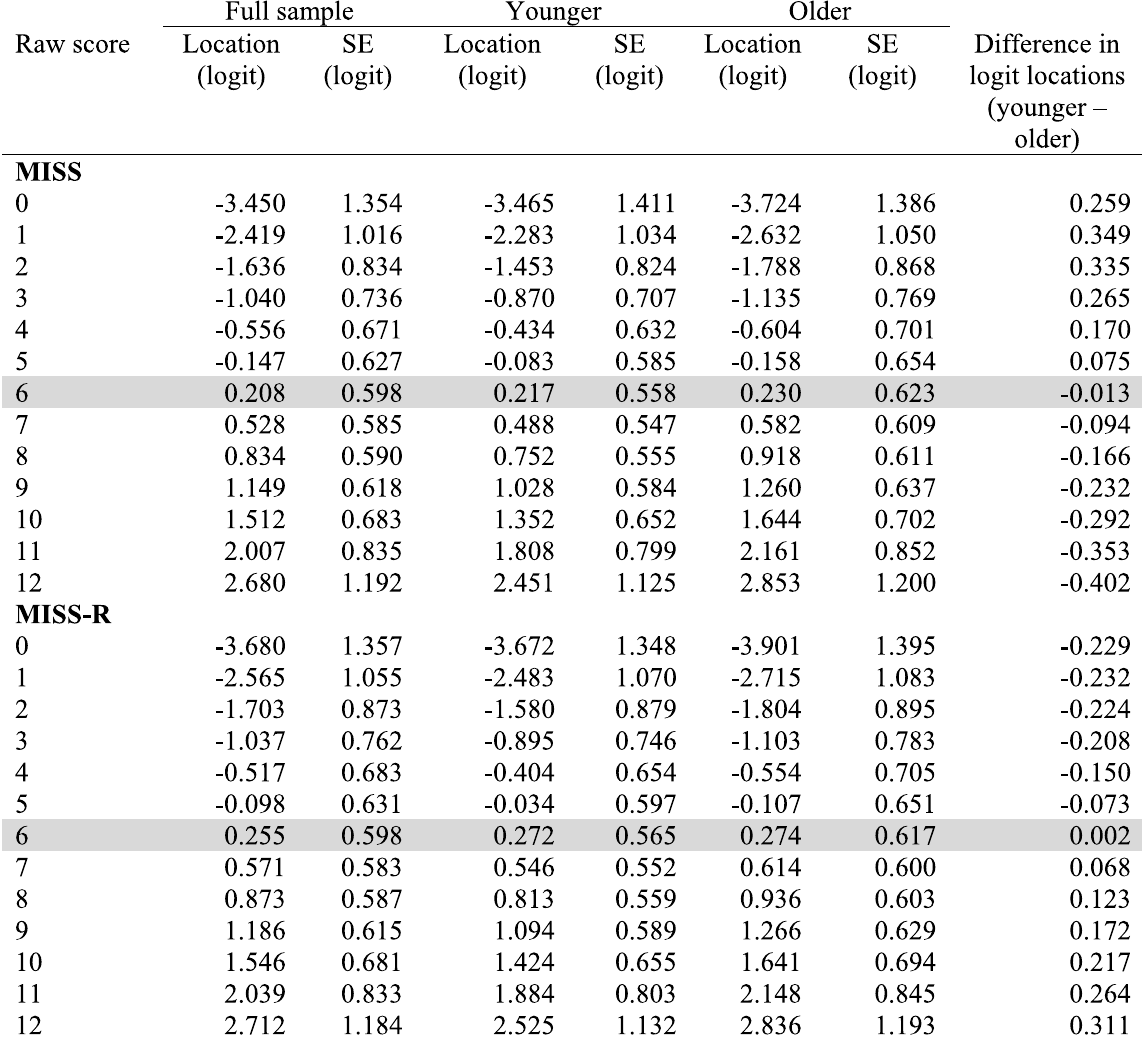
2657 and n 2601, = =